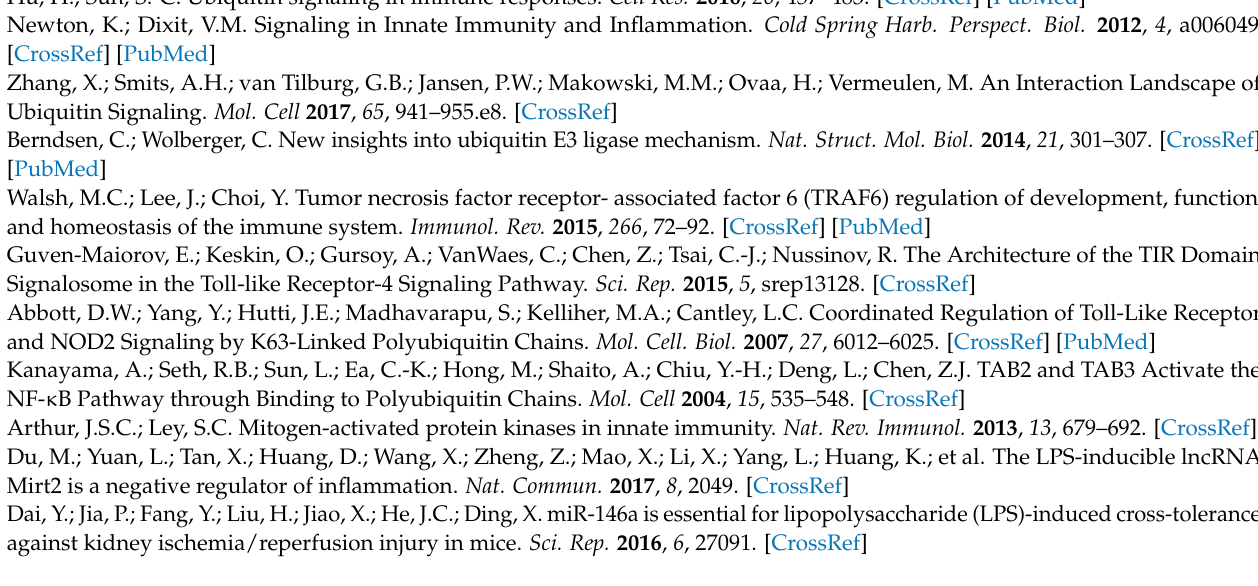
were tested for the occurrence of genetic changes by PCR and sequencing. The underlined areas were deleted and the G was inserted as shown, leading to frame-shifts and defect TRAF6 expression, Figure S3: HeLa cells were exposed for the indicated periods to EBSS medium and analyzed by Western blotting for expression of the indicated proteins, Figure S4: The indicated cell lines were incubated with EBSS medium for 5 h as shown and simultaneously treated with increasing amounts of the proteasome inhibitor Lactacystin (5, 10 µ M), Figure S5: The Venn diagrams show the number of phosphopeptides measured under the indicated conditions in the various cells. The numbers in the brackets indicate (all P-peptides; unique P-peptides), Figure S6: Protein Ids mapping to the unique groups of deregulated phosphopeptides shown were further used to perform an overrepresentation (ORA) analysis using Metascape, Figure S7: HEK293 cells expressing Flag-IKK ε alone or along with His6-ubiquitin and the indicated TRAF6 variants (C70A: defective in E3 ligase function; K124R: defective in autoubiquitination; R88A and R88A/F122A: defective in dimerization) were lysed under denaturing conditions, Figure S8: Whole Western Blots, Table S1: Antibodies and plasmids, Table S2: Phosphoproteomic analysis. References [63–66] are referred to in Supplementary